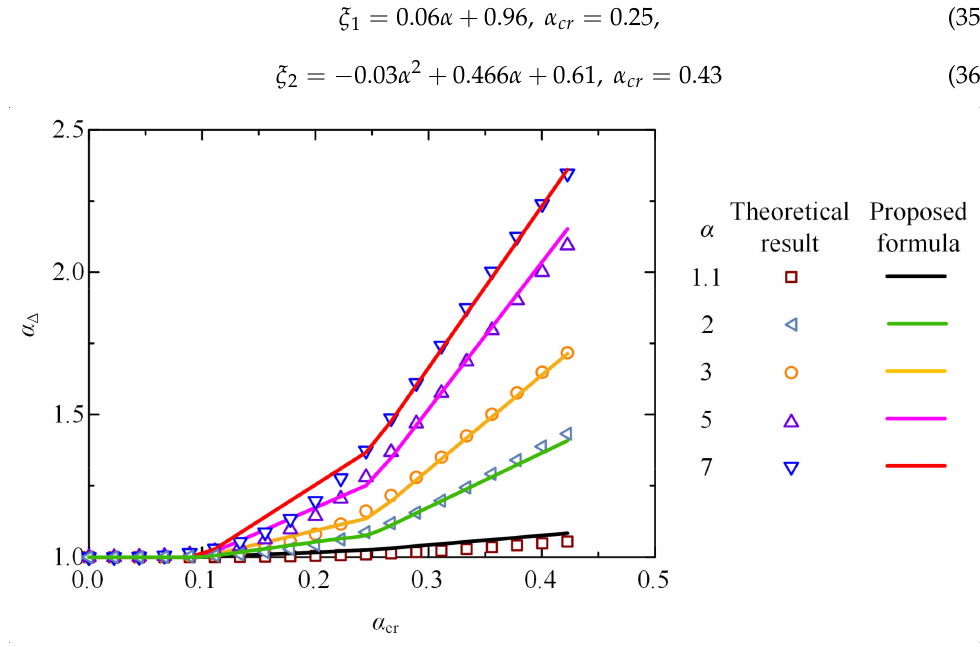
Figure 16. Variation in vertical deflection correction factor α ∆ with parameters α and α cr